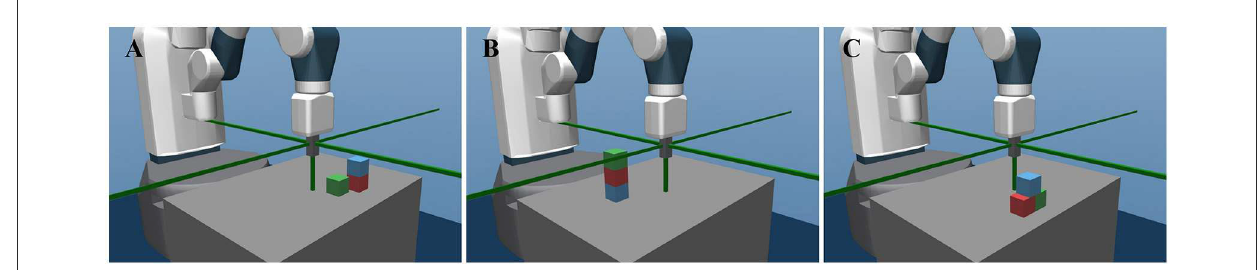
FIGURE2 The robotic manipulation environment and three examples of the semantic configurations. (A) Shows the stack of 2 blocks, with the semantic configuration [111000100]. (B) Shows the stack of 3 blocks with the configuration [110011000]. (C) Shows a pyramid with the configuration